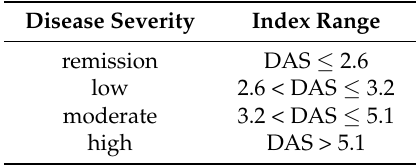
Table 1. DAS 28 scale: classification of RA